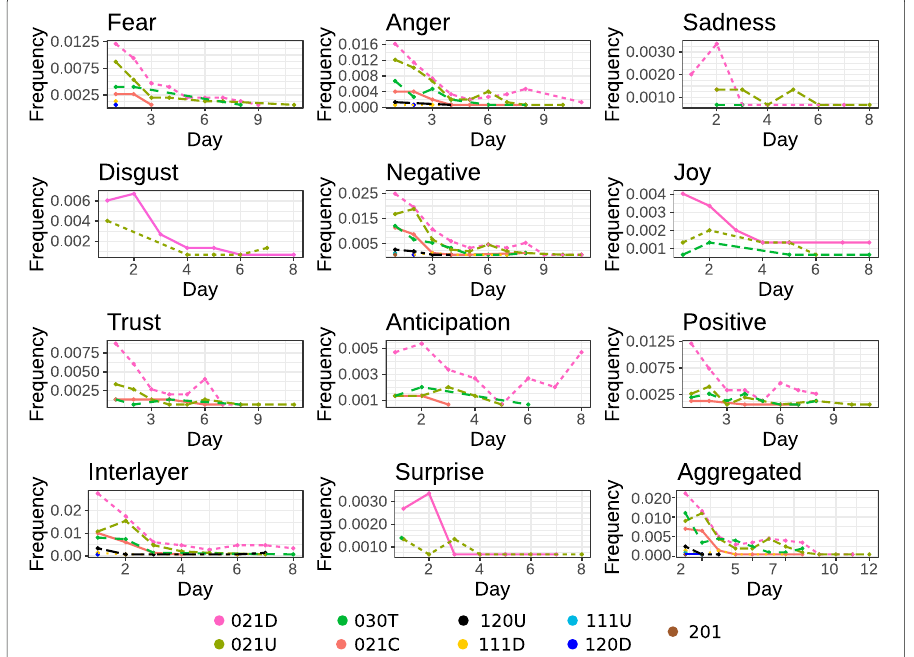
Fig. 9 Daily average number of motifs on each layer of our multiplex network. All frequency scores are normalized with respect to the overall number of motif